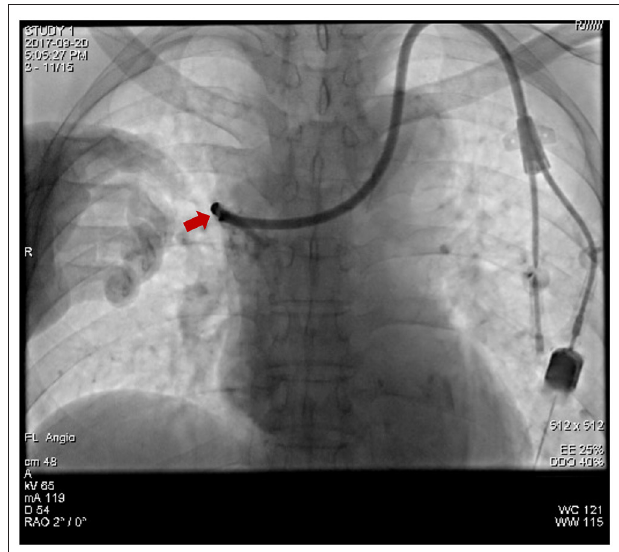
FIGURE 1 | The tip of the hemodialysis cuff catheter could not reach the upper 1/3 of the right atrial